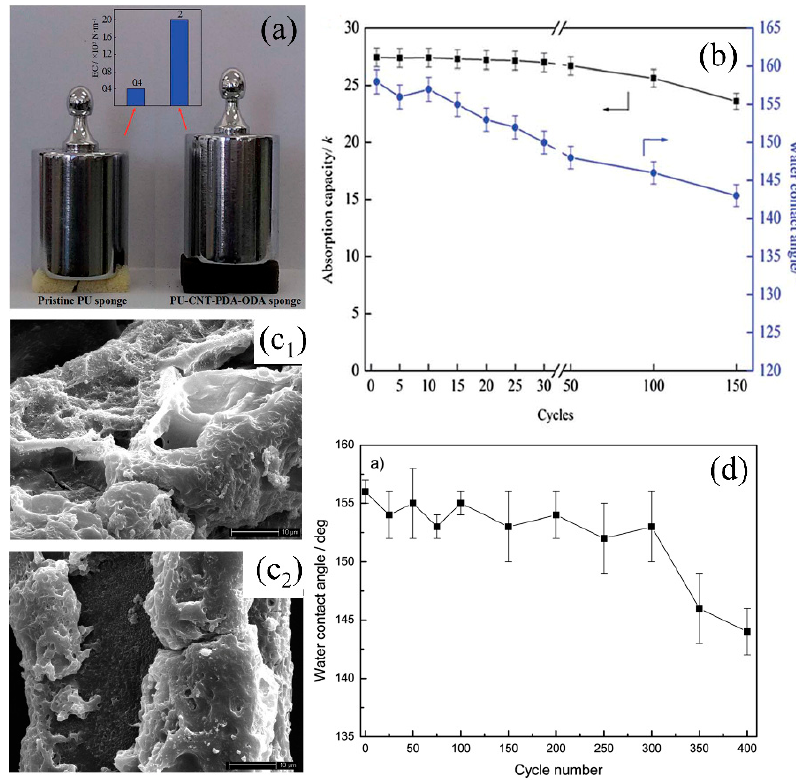
Figure 10. ( a ) Photograph of the elasticity comparison of original sponge and CNT–PDA–ODA PU sponge, ( b ) variation of the CNT–PDA–ODA PU sponge’s WCA and absorption capacity with cycles [143]. ( c ) SEM images of the methyltrichlorosilane-PU sponge for 300 ( c 1 ) and 400 ( c 2 ) cycles after water / oil separation, ( d ) variation of the methyltrichlorosilane-PU sponge’s WCA with cycles [108]; reproduced with permission from Royal Society of Chemistry.